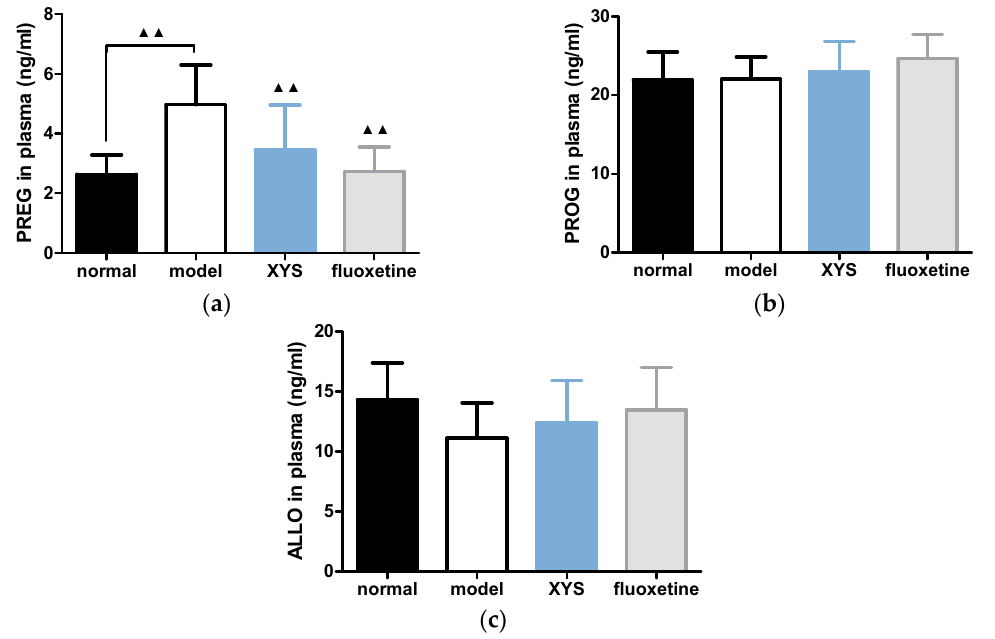
but there was no significant difference.